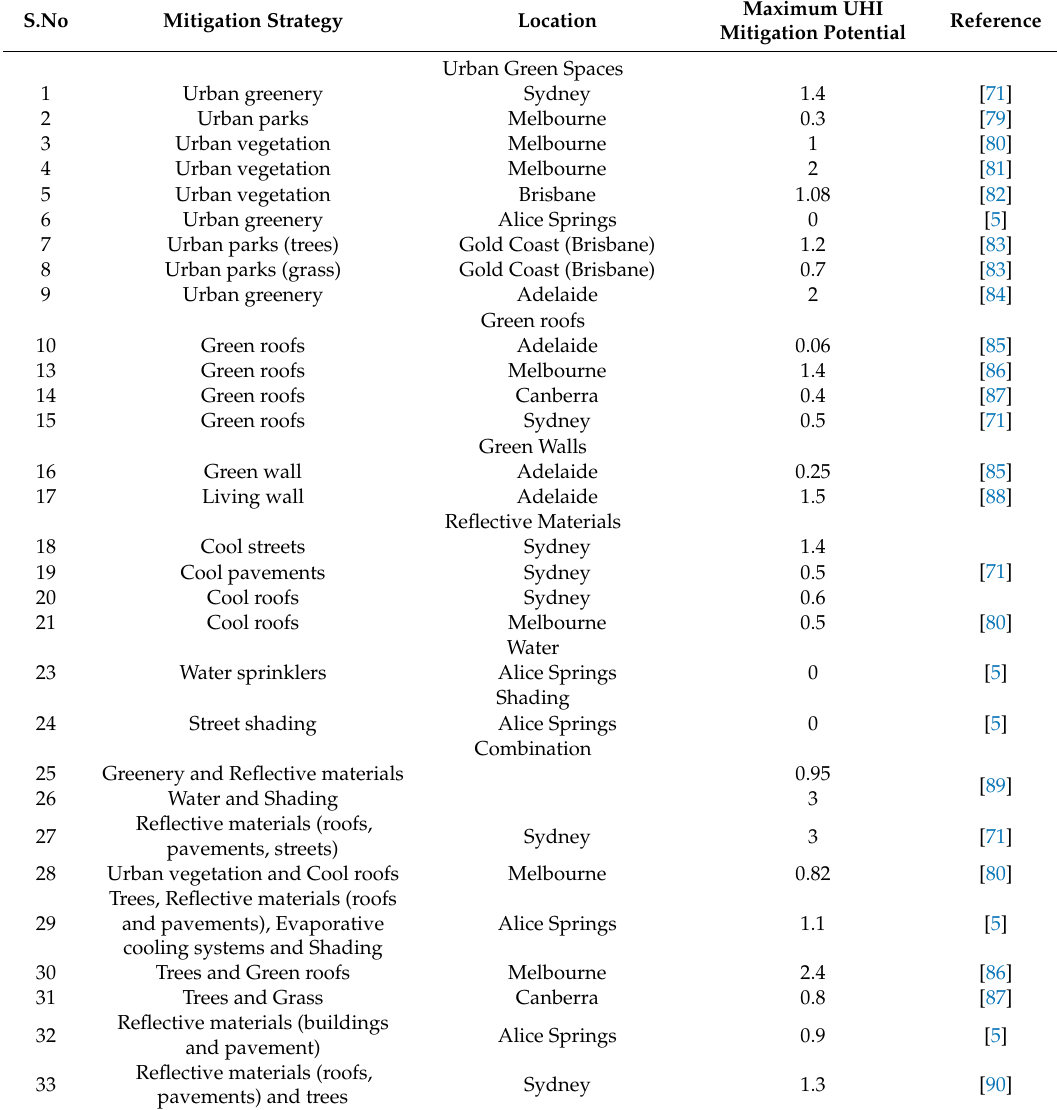
Table 2. Performance of mitigation strategies reported in Australian